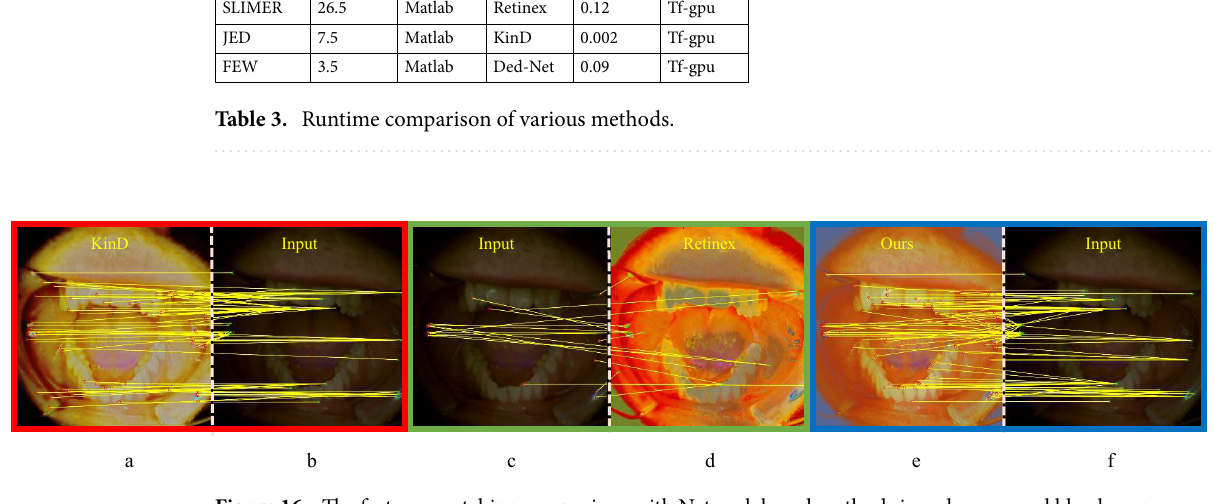
Figure 16. The features matching comparison with Network based methods in red, green and blue boxes. Feature points are matched for ( b , c , f ) input images. ( a ) shows KinD, ( d ) Retinex and ( e ) shows results for matched feature points for